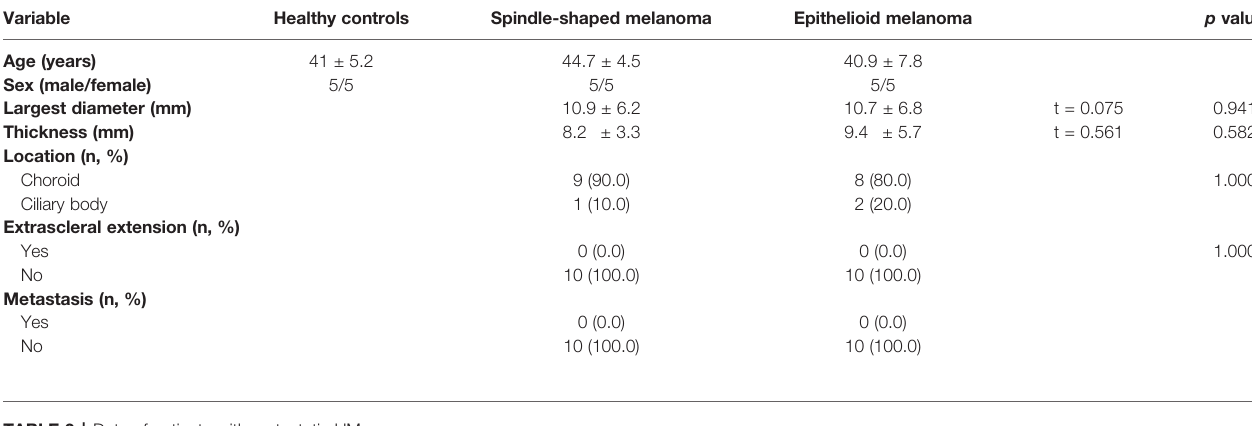
TABLE 2 | Data of participants in this study.